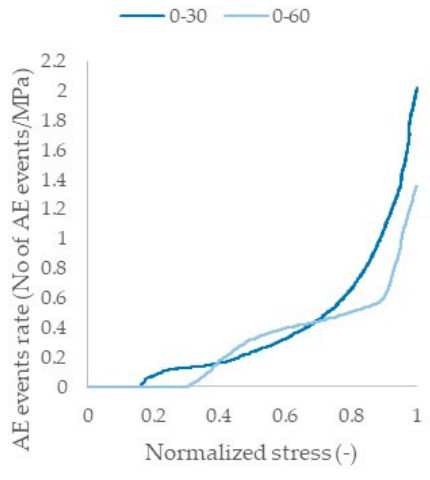
Figure 16. Total AE events recorded for the two laminates during the static tests.